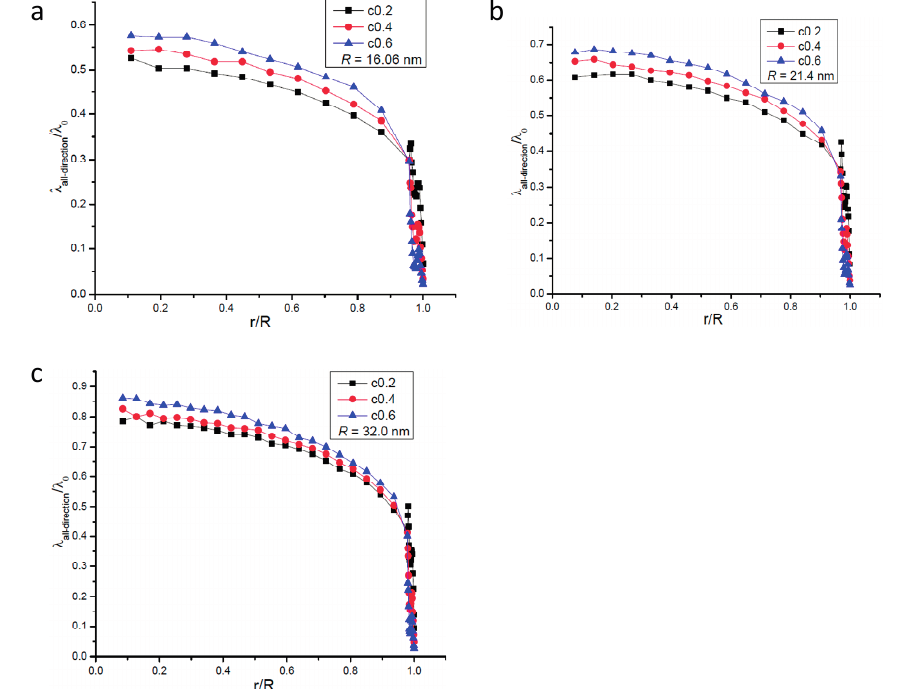
Figure 1. Variation of gas molecular mean free path with the distance from the center of the nanopore. ( a ) R = 16.06 nm; ( b ) R = 21.4 nm; and ( c ) R =32.0